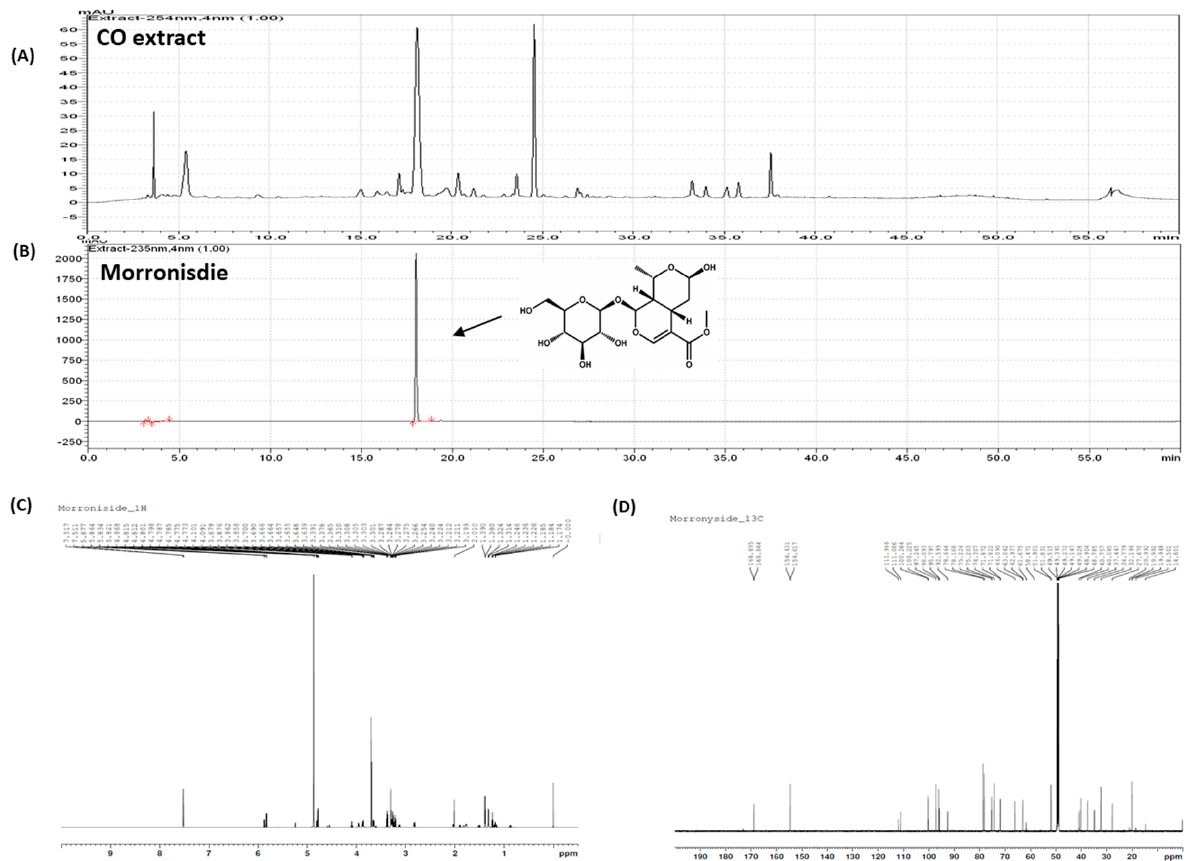
Figure 2. HPLC chromatogram of ( A ) total CO extract and ( B ) standard morroniside compound and ( C ) 1D and ( D ) 2D NMR spectrometry. HPLC, high-performance liquid chromatography; CO, Cornus officinalis; NMR, nuclear magnetic res- onance .